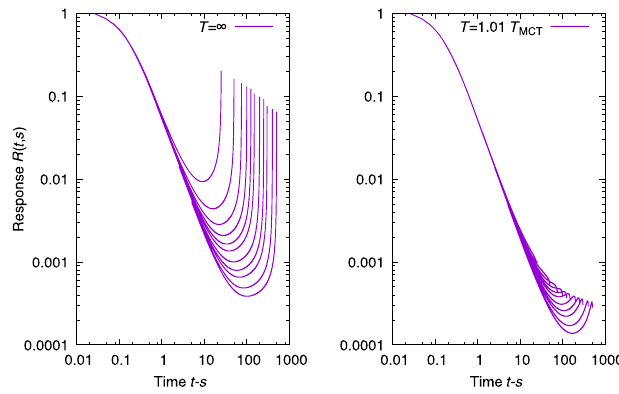
FIG. 24. Response function R ð t; s Þ with T ¼ ∞ (left panel) and T ¼ 1 . 01 T (right panel), as a function of the time difference MCT t − s for t ¼ 25 , 50, 75, 100, 125, 150, 200, 250, 300, 400, and 500. It is evident that the response is much smaller starting from finite temperature.